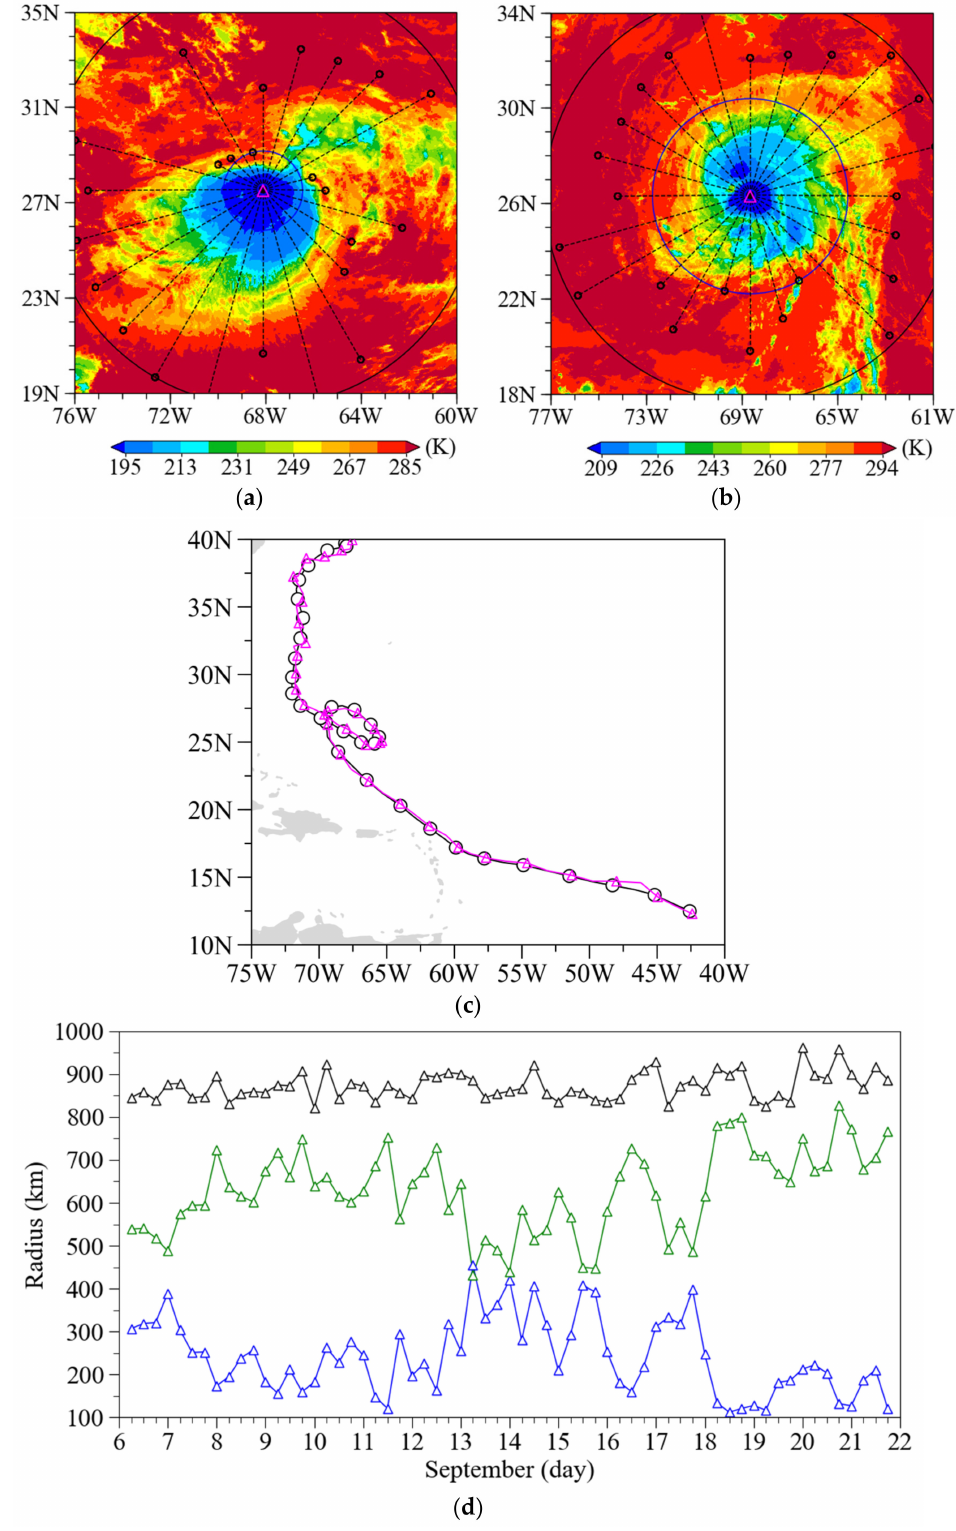
Figure 8. ( a , b ) Same as Figure 4a,b except for Jose at about ( a ) 1200 UTC September 12 and ( b ) 1200 UTC September 15, 2017 ( c , d ) Same as Figure 6a,b except for Jose from 0600 UTC September 6 to 1800 UTC September 21,